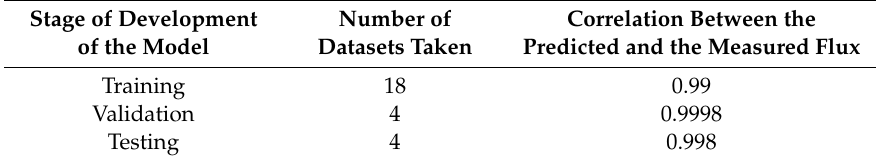
Table 4. Performance of the ANN model for predicting N 2 O emissions, during the training and testing phases.